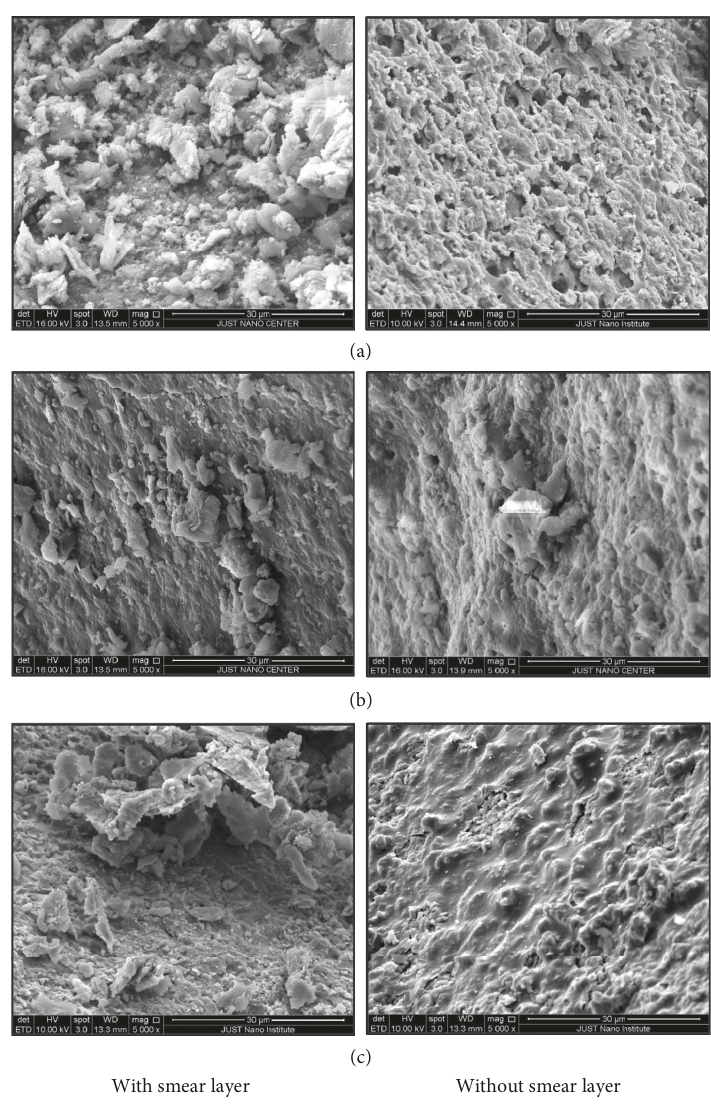
Figure 3: SEM images of root canal dentin surfaces that were filled with; (a) MTA, (b) Biodentine, and (c) TotalFill FS, with a smear layer preserved (left side, with smear layer) and after removal of smear layer (right side, without smear